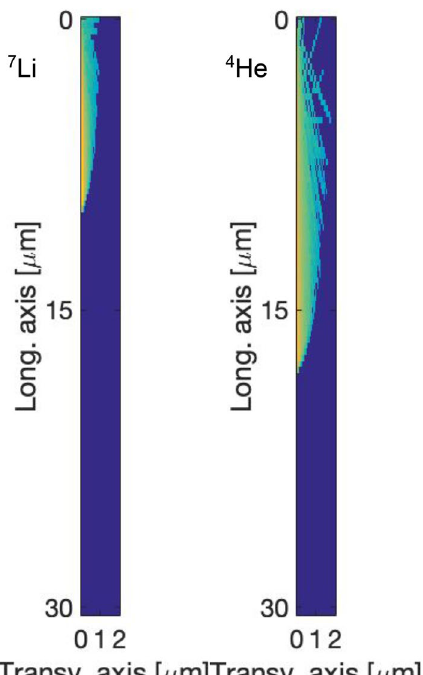
Figure 10. Ionization density distribution resulting from the high linear energy particles generated in boron neutron capture reactions in the poly(HEMA)